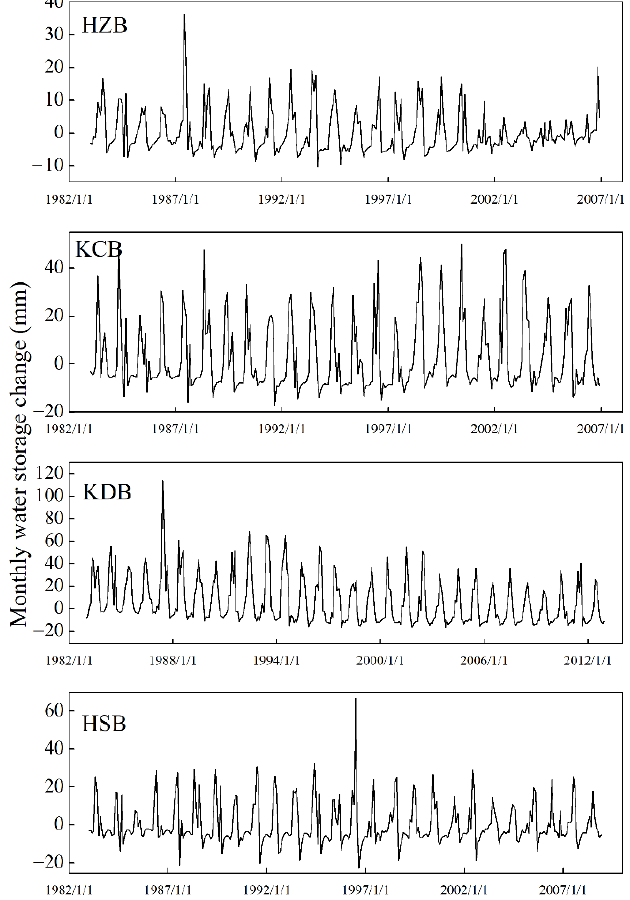
Figure A5. Monthly water storage change of the four basins derived from the abcd model.